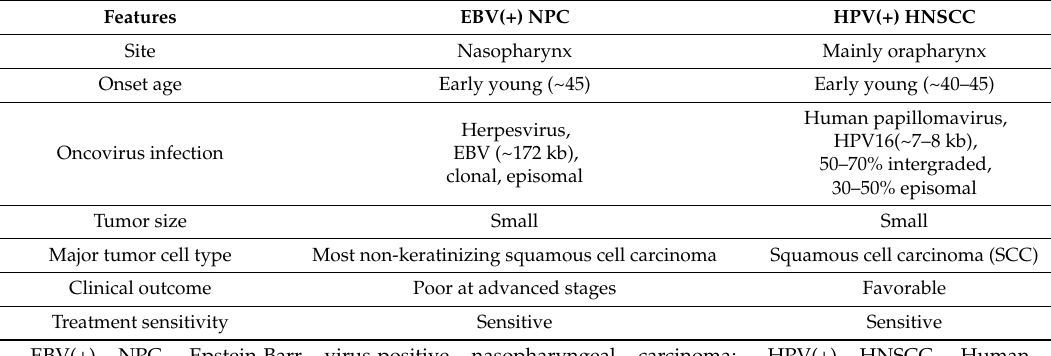
Table 1. Similarities and differences between EBV(+) NPC and HPV(+) HNSCC.